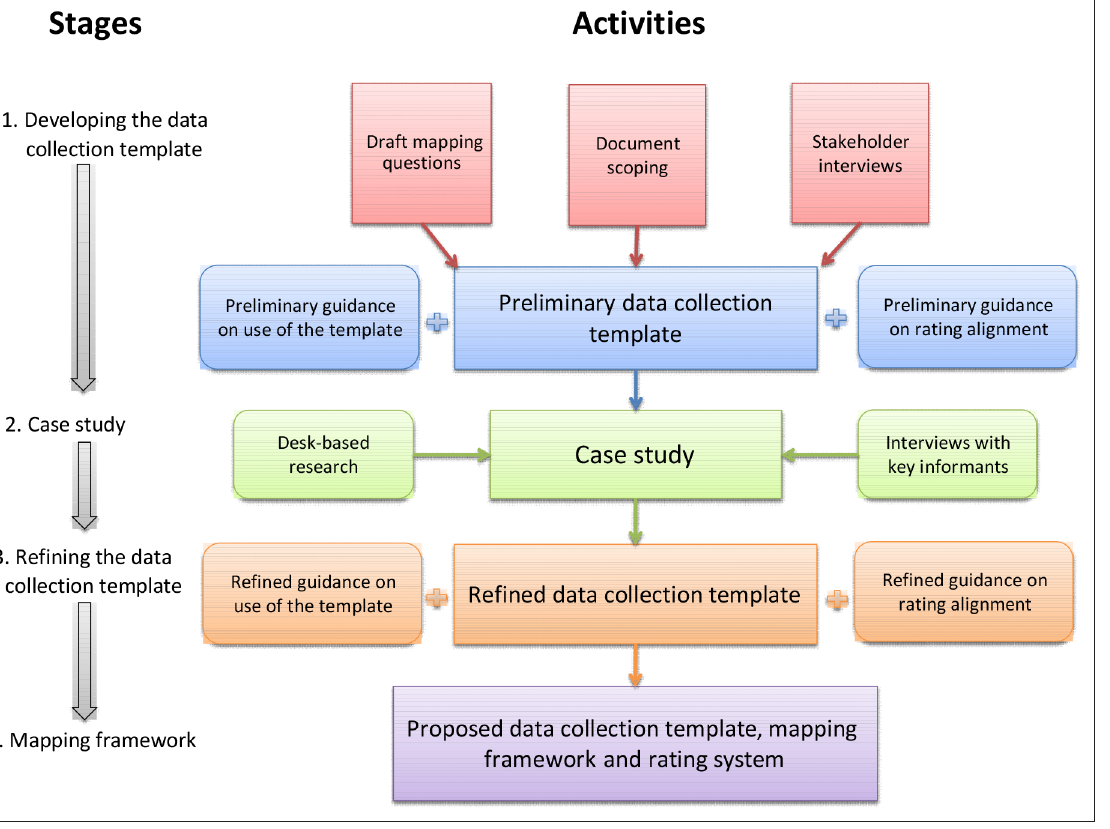
Figure 1 Stages and activities involved in developing and piloting the mapping